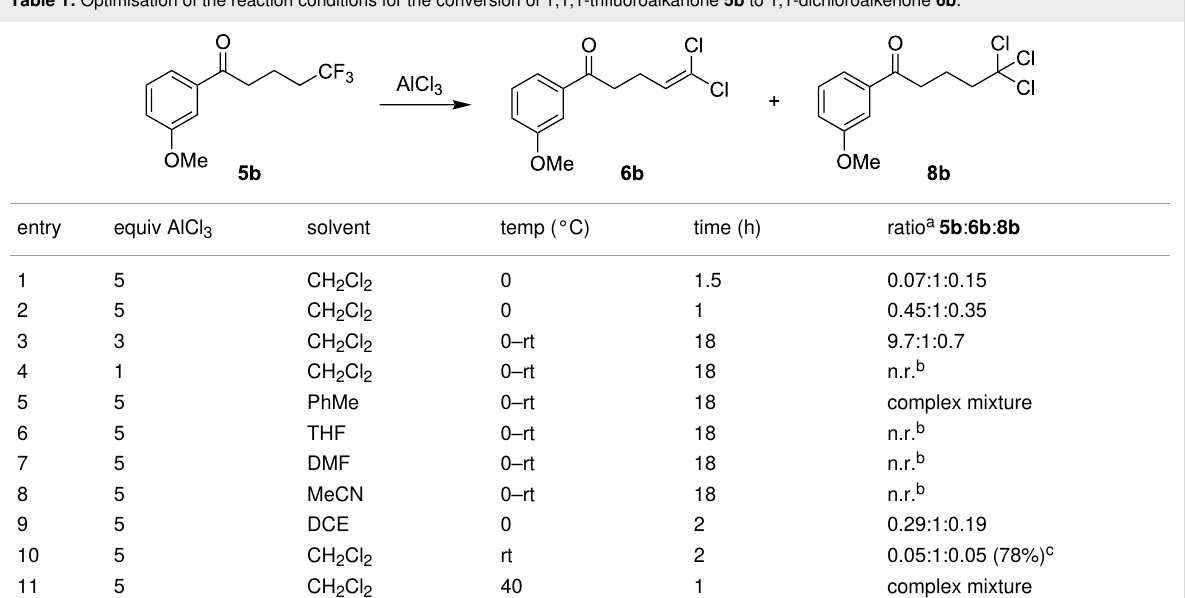
Table 1: Optimisation of the reaction conditions for the conversion of 1,1,1-trifluoroalkanone 5b to 1,1-dichloroalkenone 6b .